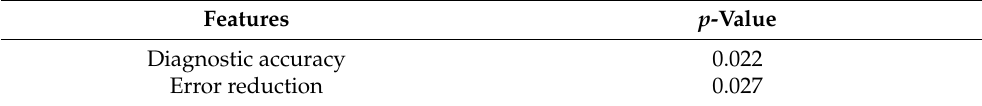
Table 2. ANOVA test of the AI application on prosthodontics.